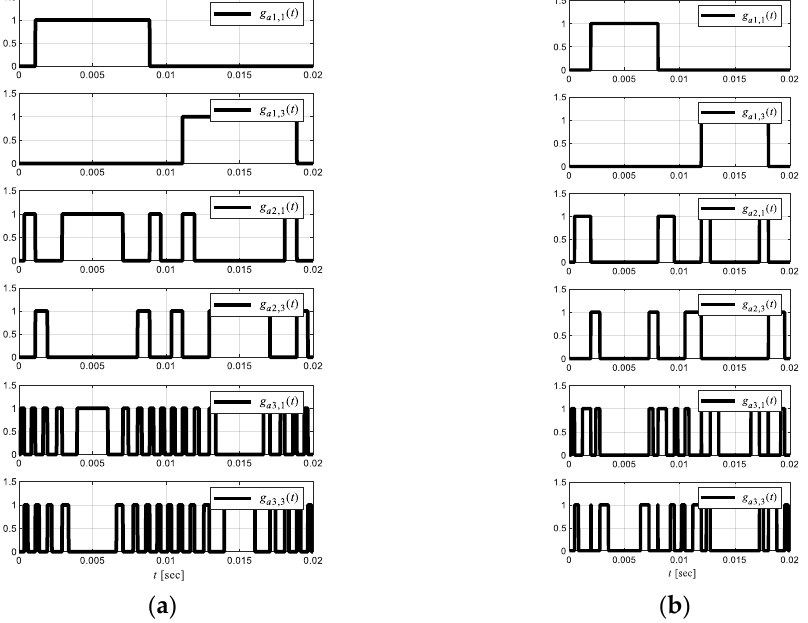
Figure 6. Gate signals for semiconductors devices of 27-level single – phase asymmetric inverter with regeneration. ( a ) m = 1.0, ( b ) m =0.7.